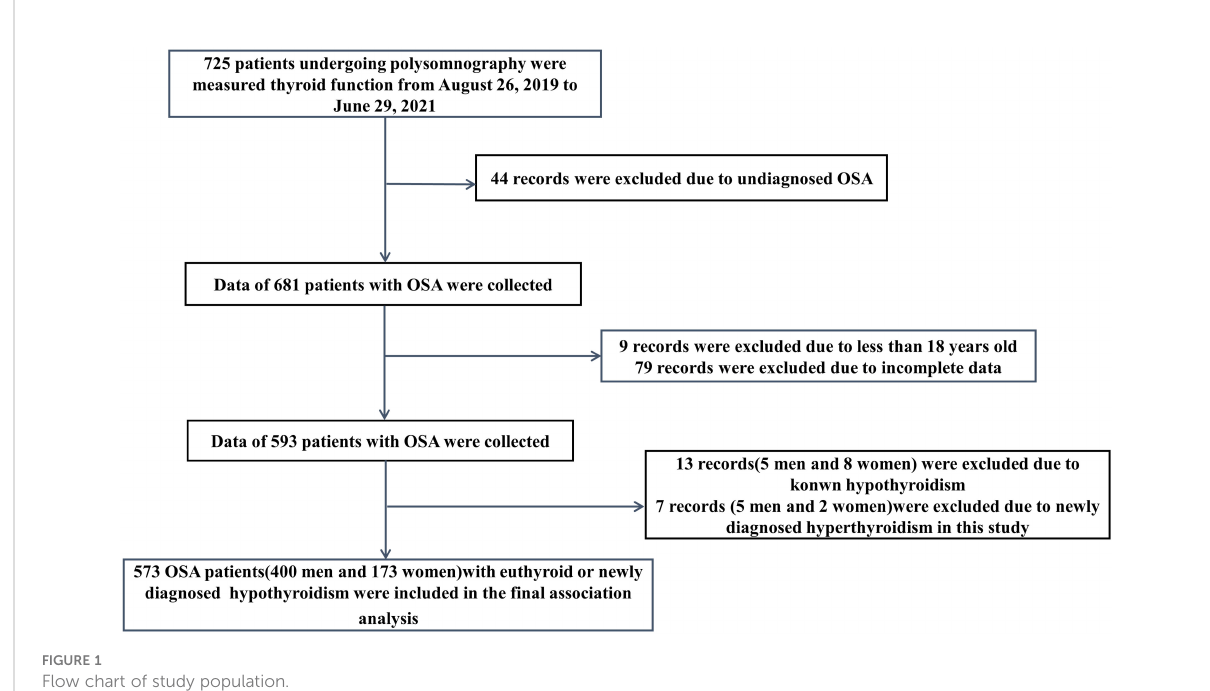
FIGURE 1 Flow chart of study